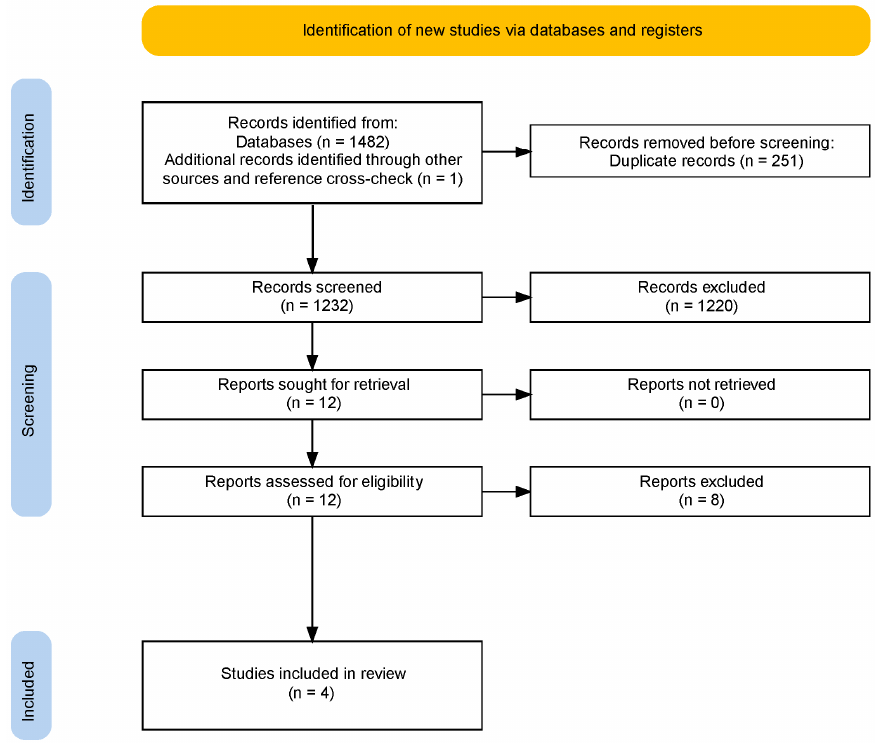
Figure 2. PRISMA flow chart.